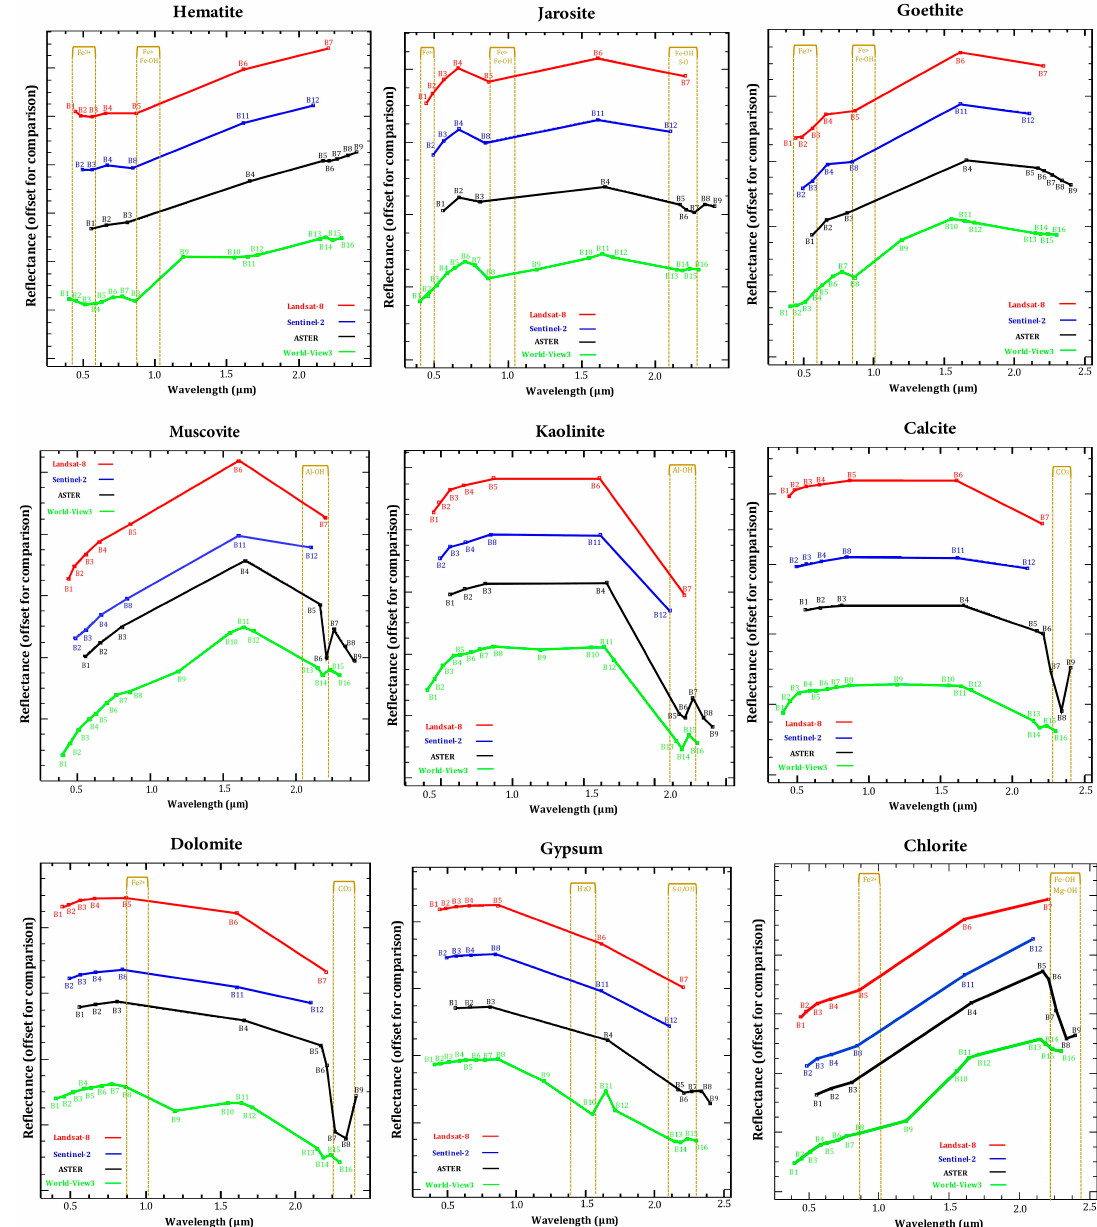
Figure 3. The laboratory reflectance spectra of hematite, jarosite, goethite, muscovite, kaolinite, calcite, dolomite, gypsum and chlorite resampled to response functions of VINR+SWIR bands of Landsat-8, Sentinel-2, ASTER and WV-3. Cubes indicate the position of the VINR+SWIR bands of Landsat-8, Sentinel-2, ASTER and WV-3 in the range of 0.4 µm to 2.5 µm. The main absorption feature spectra attributed to Fe +2 , Fe +3 , OH, H 2 O, Fe-OH, S-O, Al-OH, Fe, Mg-OH, and CO 3 are delimited by dashed rectangles. The VNIR spectral bands of WV-3 have high potential to map Fe 3+ , gossan and dolomite/Fe 2+ . Ferric/ferrous iron oxides contain a set of absorption features about 0.40 to 1.2 µm, which are